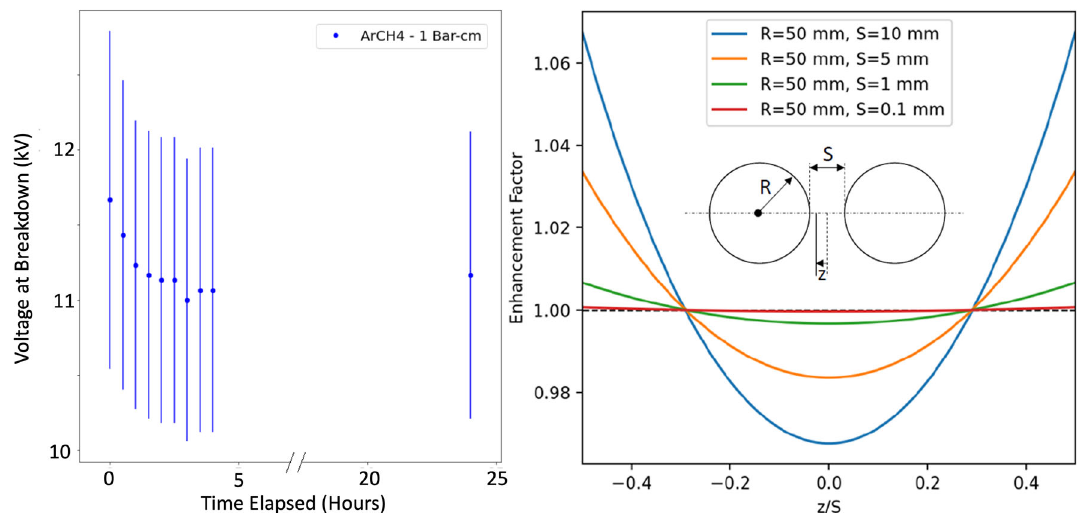
Fig. 3 Left: Breakdown voltage as a function of the time elapsed after pressurizing to 1 bar of Ar–CH 4 ; Right: calculation of enhancement factors of electric field relative to parallel plate geometry as a function